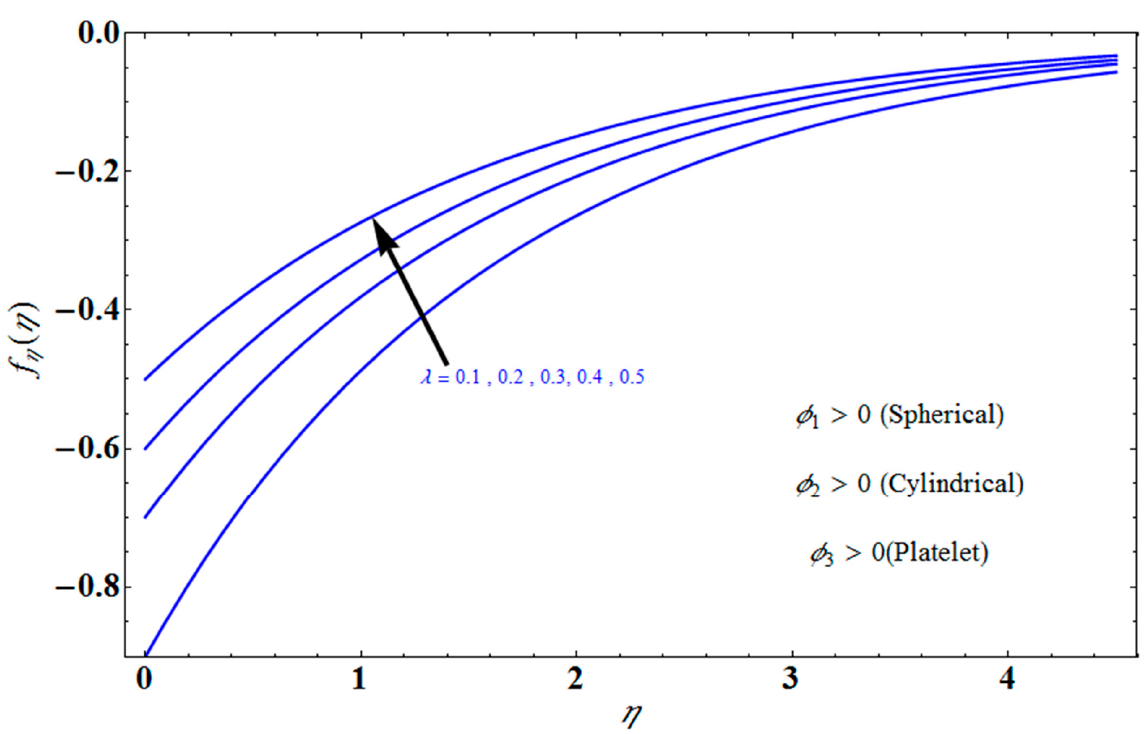
( ) η η f on for several values of ( ) η η η f on for several values of η